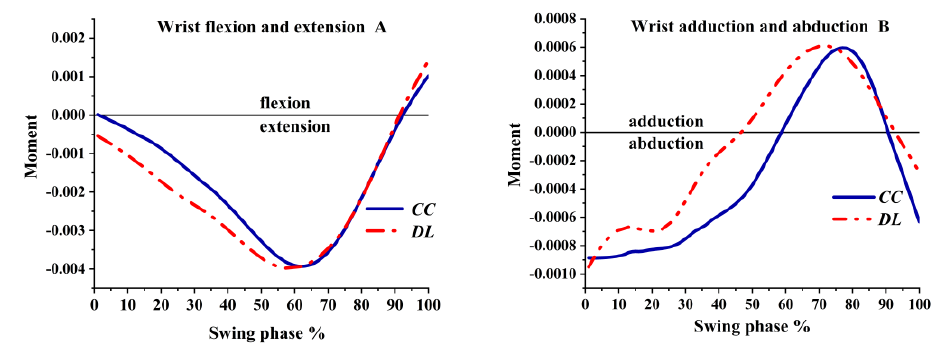
Figure 11. The moment of wrist joint during swing phase.